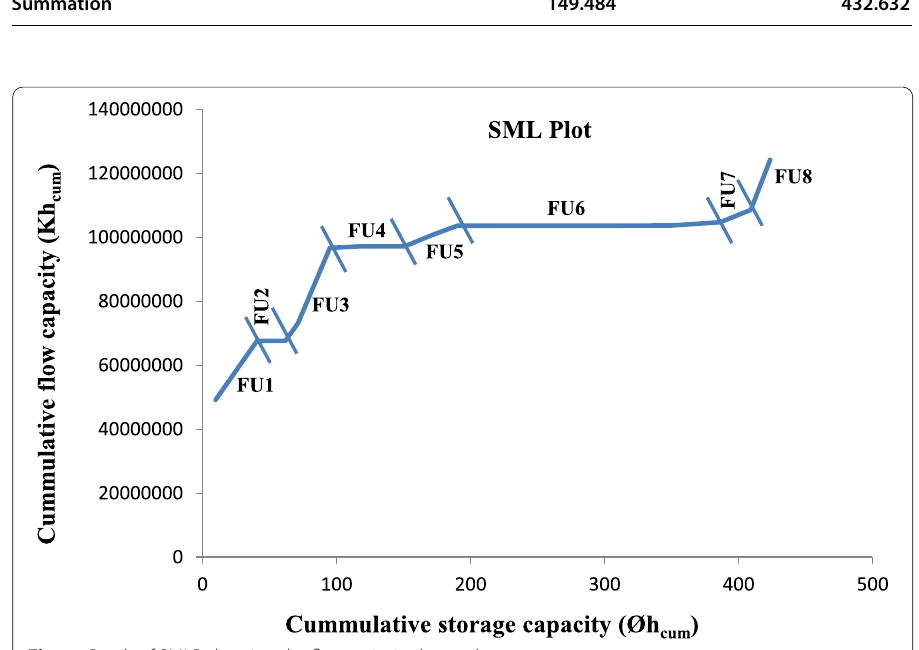
Fig. 4 Graph of SMLP showing the flow units in the study